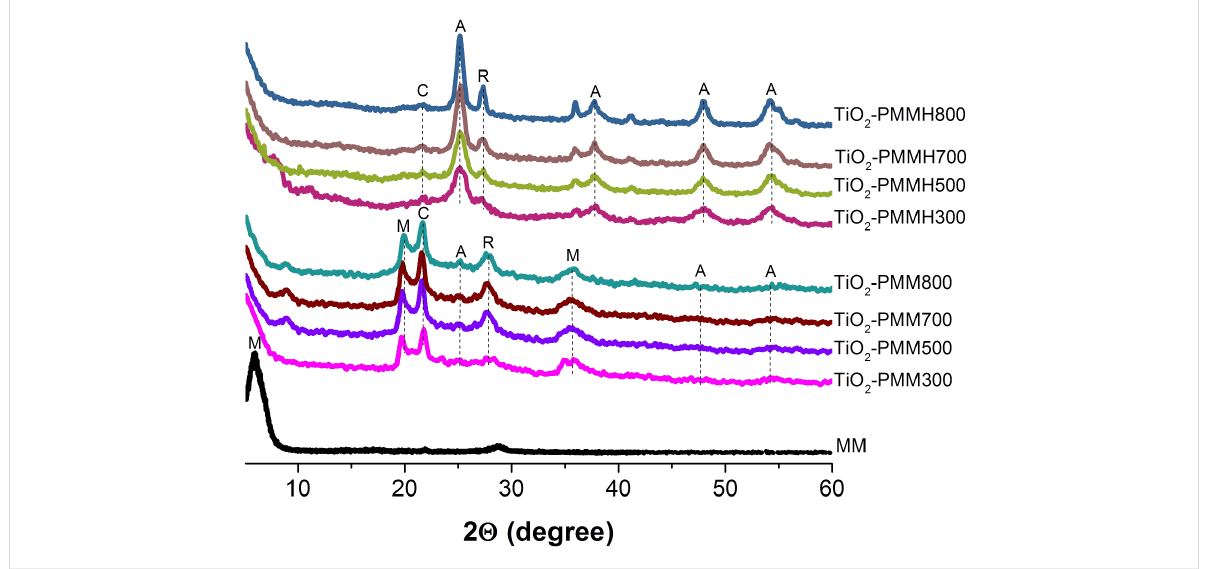
Figure 2: XRD patterns of the raw MM and TiO 2 -PMM x , and TiO 2 -PMMH x , where М , C, А , and R represent montmorillonite, cristobalite, anatase, and rutile phases, respectively.